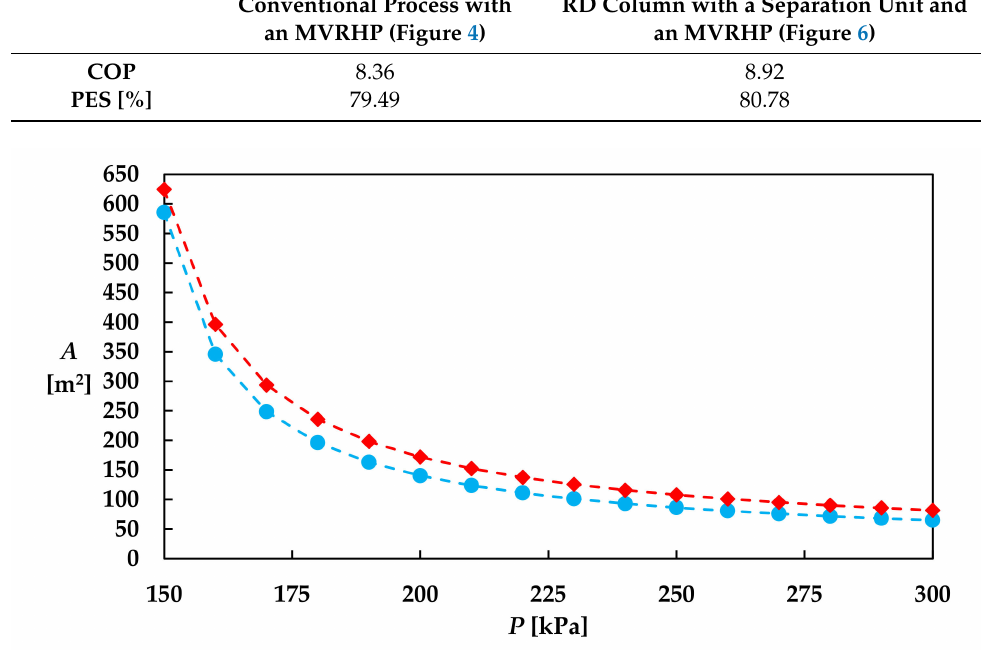
Figure 7. Effect of compressor discharge pressure on the required column reboiler heat exchanger area; blue circles—conventional process with an MVRHP (Figure 4), red diamond—RD with a separation unit and an MVRHP (Figure